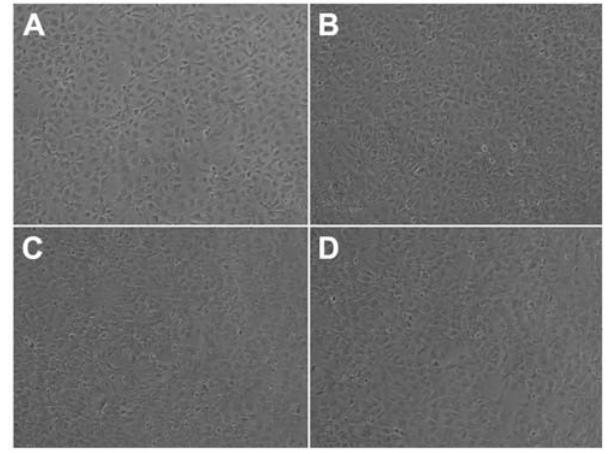
Figure 5. Effect of solTNF a on NSC survival. 3 concentrations of solTNF a (0.1 m M, 1 m M and 10 m M) were added to freshly seeded NSC cultures. Cells were evaluated up to 24 hours for signs of cell death. No increase in cell death relative to untreated cultures was observed in the cultures treated with solTNF a . The images taken of the cells treated with 0.1 m M of solTNF a , are representative of data obtained for all concentrations and are shown at (A) 1 hour, (B) 4 hours and (C) 24 hours post cytokine treatment. (D) Untreated cells are shown at 24 hours for comparison.